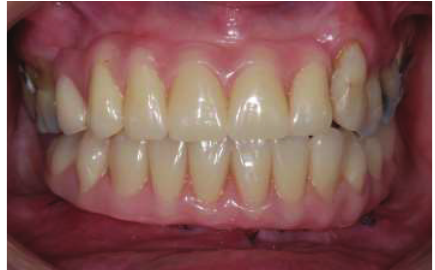
Figure 5: Framework after finishing.